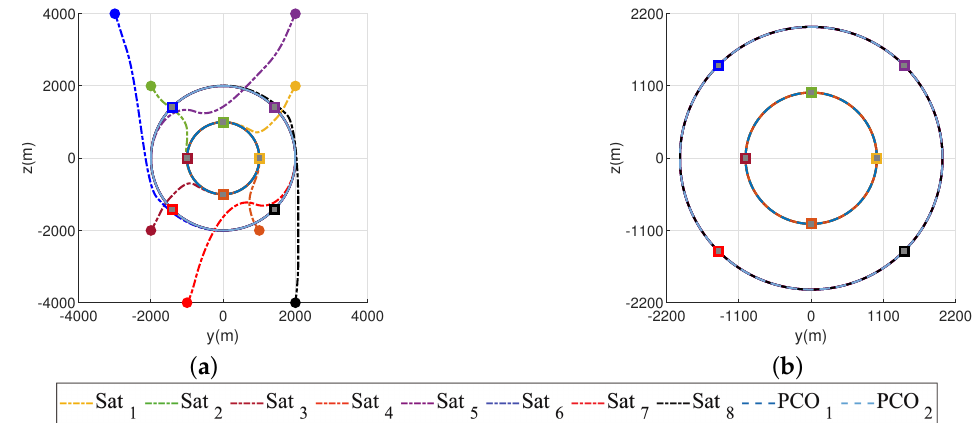
Figure 5. PD law. Trajectories plots: ( a ) on plane YZ; ( b ) on plane YZ after orbiting.